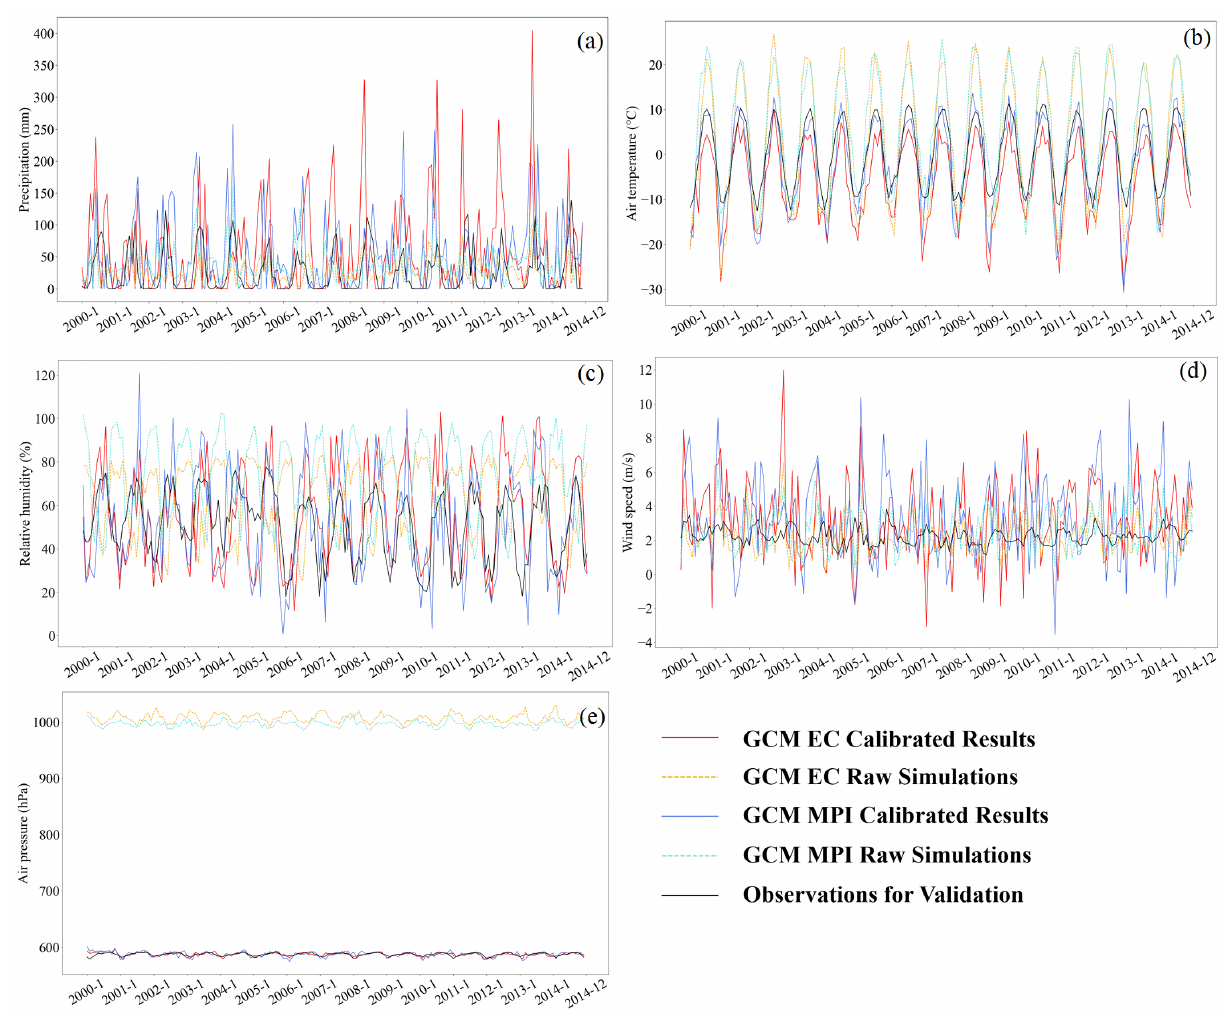
Figure 4. Time series of the pre-adjustment GCM simulations, calibrated results, and the observations in the last adjustment (the results in the 2000 – 2014 period) for the variables at the Naqu site. Raw simulations: pre-adjustment data from the EC and MPI GCM simulations; calibrated results: post-adjustment results; validation: the corresponding observations in 2000 – 2014. Subplots ( a – e ) correspond to precipitation, air temperature, relative humidity, wind speed and air pressure.